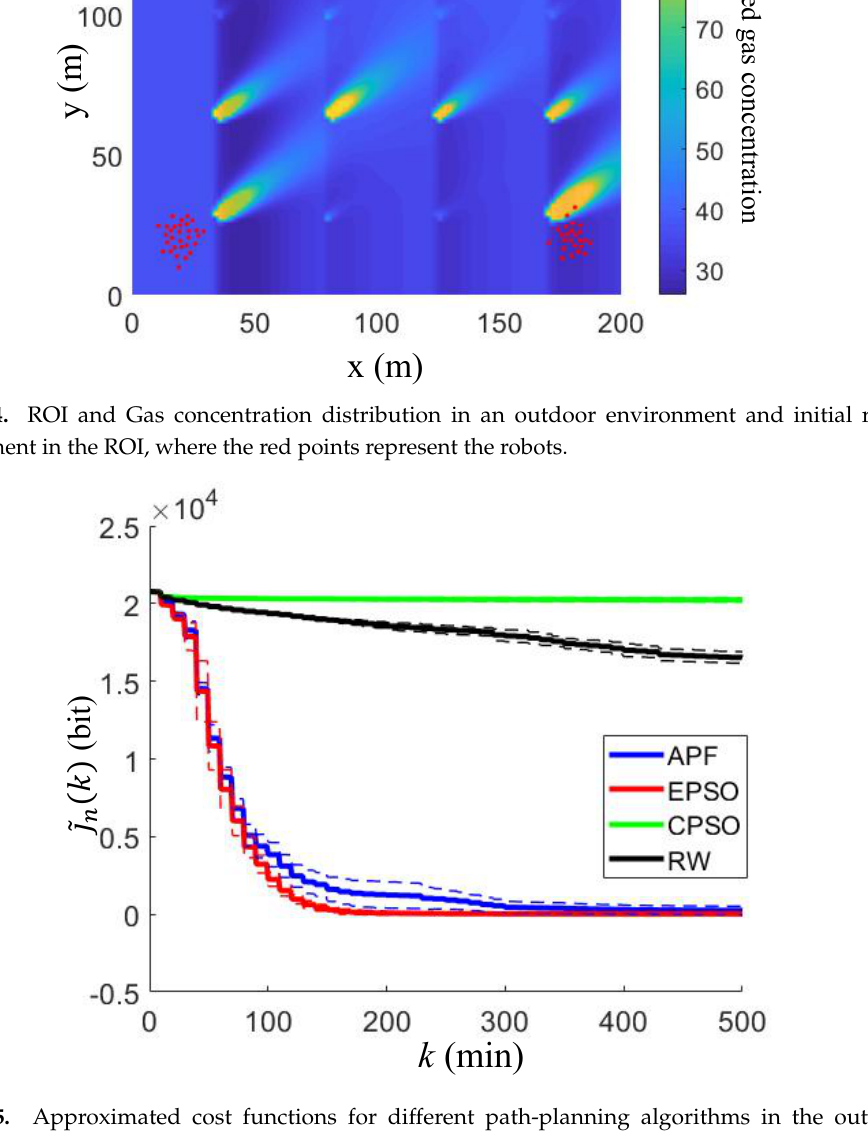
Figure 5. Approximated cost functions for different path-planning algorithms in the outdoor environment, where the solid lines represent the mean of the approximated cost values over all the robots at the k th time step and the dashed lines indicate one standard deviation above and below the solid